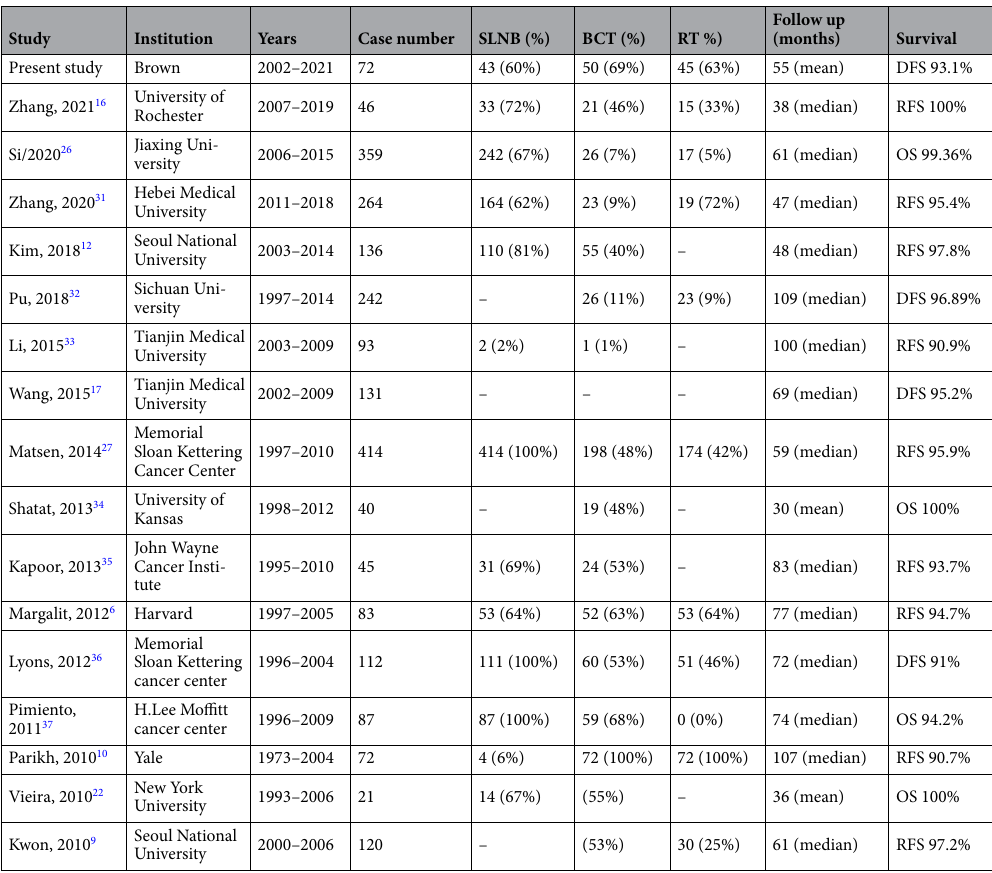
Table 3. Significant literature based on the 1 mm AJCC categorization of MIBC. AJCC American Joint Committee on Cancer, SLNB sentinel lymph node biopsy, BCT breast conservative therapy, RT radiation therapy, DFS disease free survival, RFS recurrence free survival, OS overall